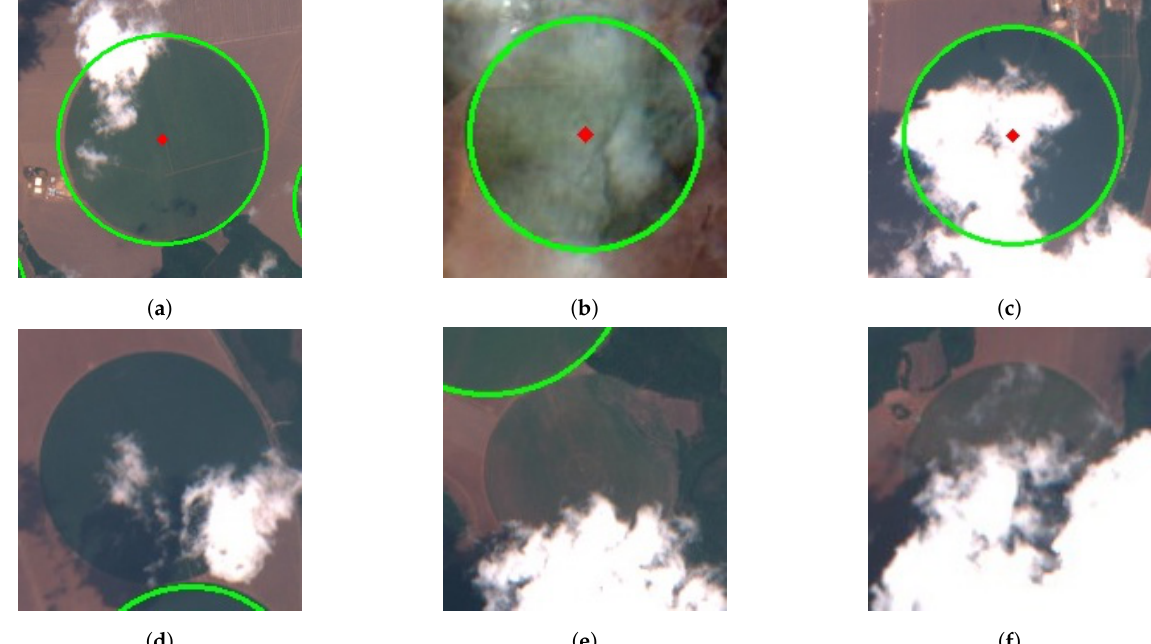
Figure 15. Center pivot irrigation systems with cloud cover. ( a – c ) Center pivot irrigation systems with cloud cover successfully detected. ( d – f ) Missed detection of center pivot irrigation systems due to cloud cover.